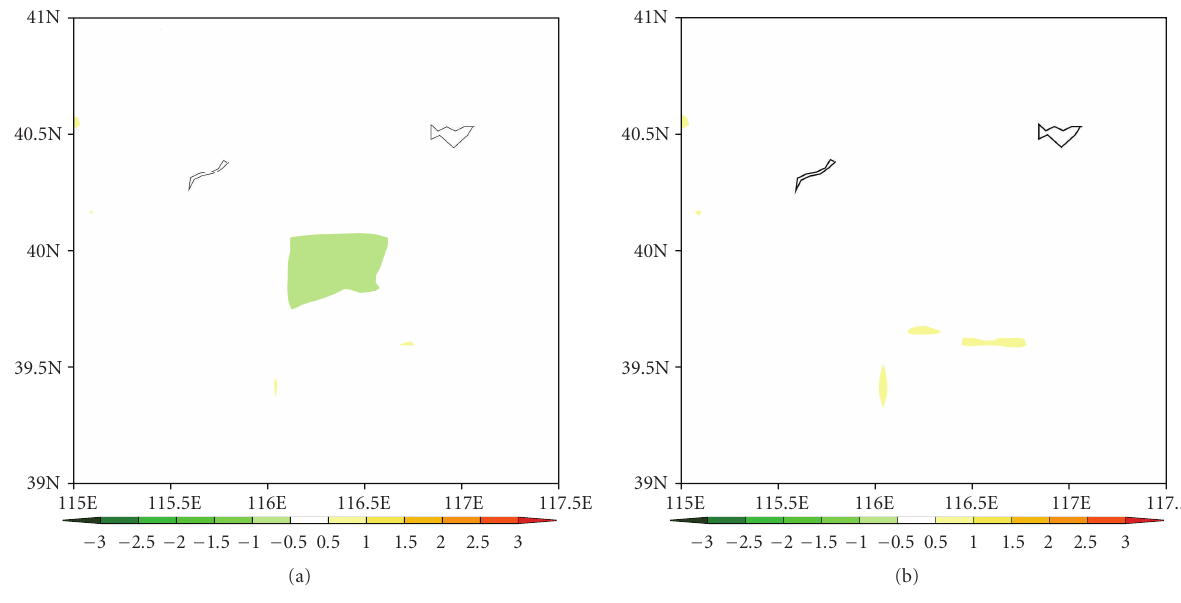
Figure 10: Same as Figures 9(c) and 9(d)) except for 18Z, July 27, 2008. (a) The di ff erence of T skin between sensitivity run and the control run, and (b) same as (a) except for T air .